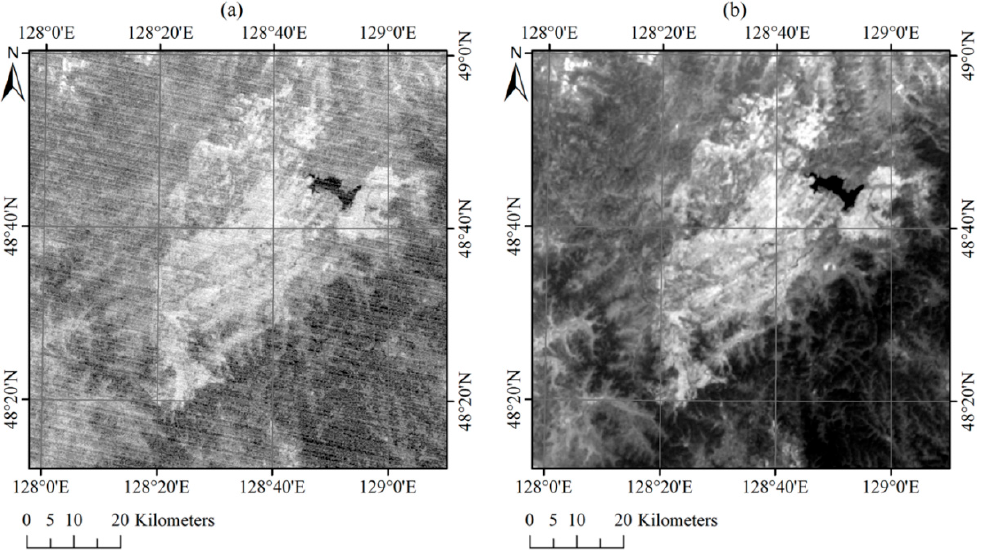
Figure 3. Brightness temperature (BT) images from band 7 ( a ) and band 8 ( b ) acquired on 22 May 2009.